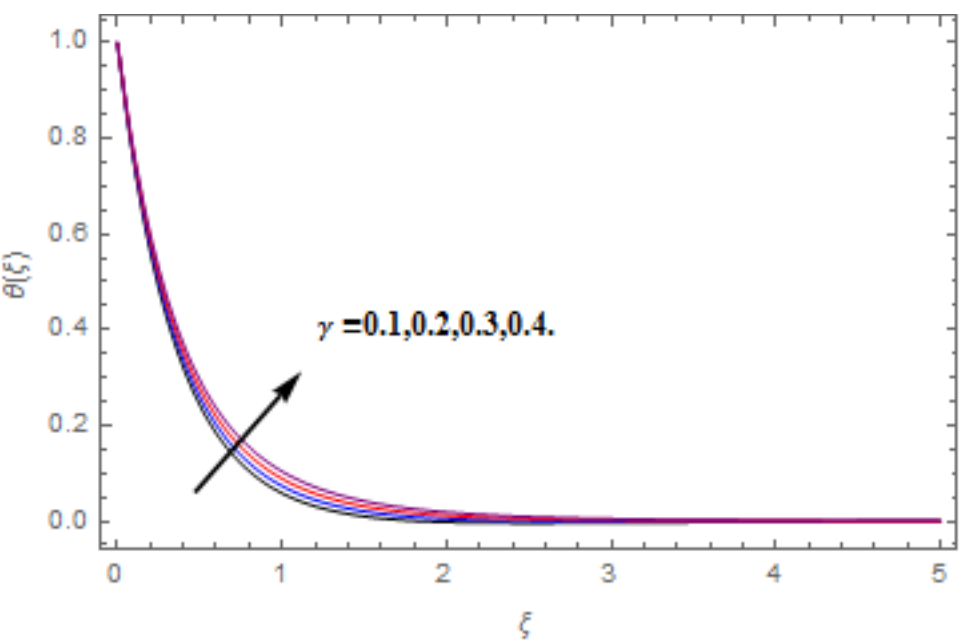
Figure11. Varationin θ ( ξ ) against γ , when M = ψ = 0.2, Nt = Nb = 0.5, Le = 1.0, Ec = 1.0, Pr = 1.2, Figure 11. Varation κ = 1.0. Molecules 2020 , 25 , x FOR PEER REVIEW